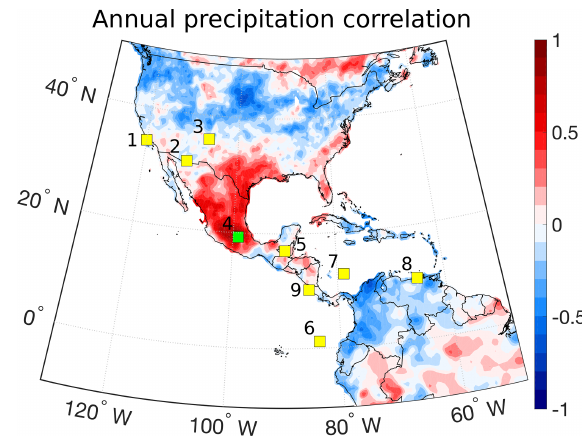
Figure 2. Locations of long paleoclimate records from the north- ern tropics and subtropics of the Americas and correlation among regional precipitation patterns. 1. Santa Barbara Basin (ODP site 893); 2. Cave of the Bells, AZ; 3. Valles Caldera, NM; 4. Lake Chalco, Mexico; 5. Lago Petén Itzá, Guatemala; 6. Panama Basin (ODP 677B); 7. Nicaragua Rise (ODP 999A); 8. Cariaco Basin (ODP site 1002); 9. Terciopelo Cave, Costa Rica. Red and blue shading depicts the correlation ( r ) between annual precipitation at Chalco and all the other locations (1901–2013 CE; 10-year low-pass filter; 0.5 ◦ spatial resolution). The precipitation data are the mean of three gridded products: University of Delaware v5.01 (Will- mott and Matsuura, 2001); Global Precipitation Climatology Cen- ter V7 (Schneider et al., 2016); and University of East Anglia CRU TS v. 4.03 (Harris et al.,